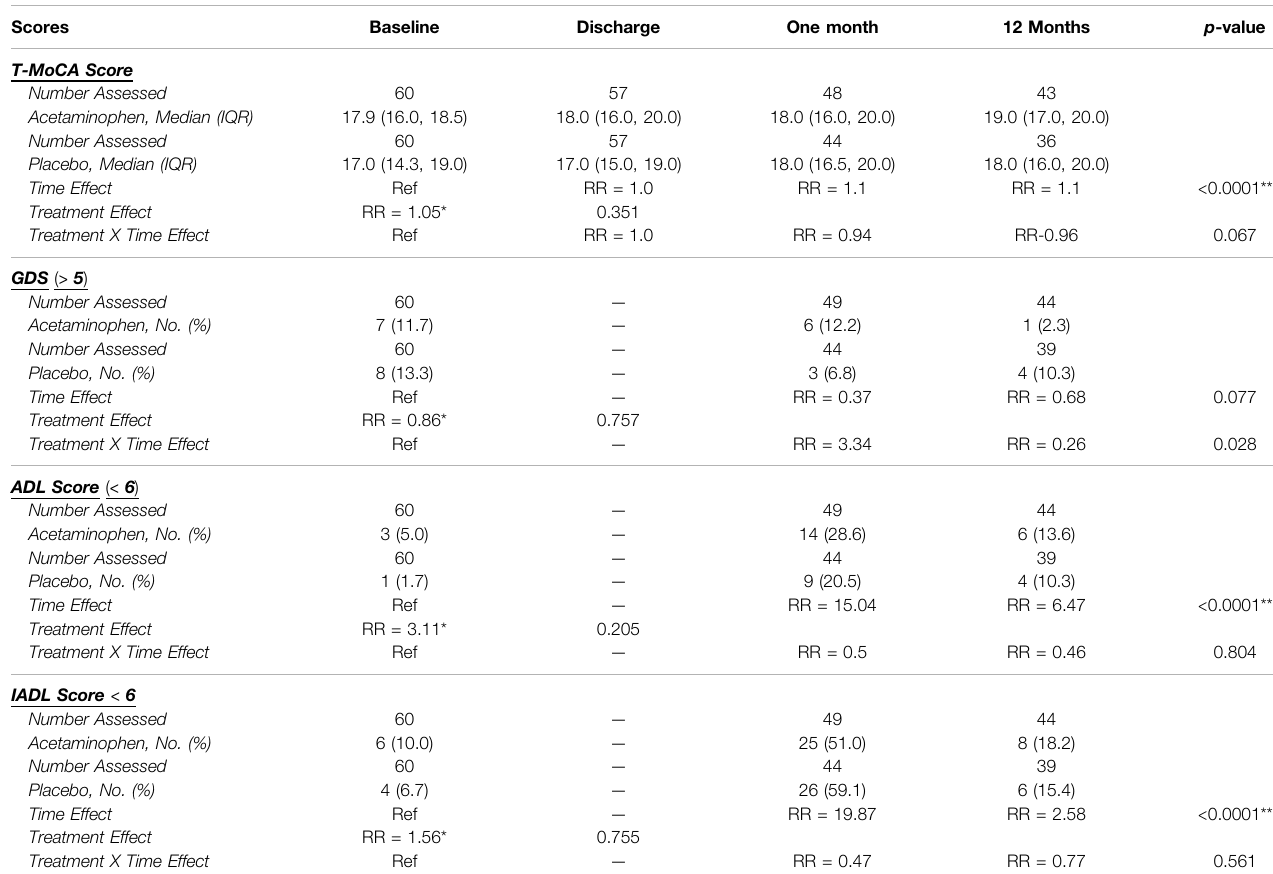
TABLE 2 | Overall Results for Cognitive and Functional Outcomes Over Time. Generalized estimating equations were performed to test whether analgesic group, time, and theirinteraction predictedT-MoCA,GDS,ADL,andIADLscores.Thenumberofpatientsassessedisdisplayed foreachoutcomeasitvariesover timeandbytreatment groupduetowithdrawals,assessmentsrefused,etc.Median(IQR)aredisplayedforT-MoCAscoresandFrequency(%)aredisplayedforGDS,ADL,andIADLscoreswhich have been dichotomized. Risk ratios are displayed for the time effect with baseline as the reference, for the treatment effect with placebo as the reference, and for the time*treatment interaction with baseline-placebo as the reference. A signi fi cant time effect was found for T-MoCA, ADL, and IADL. Although the GDS treatment*time interaction p -valueis < 0.05,becausetheprimarycomparisonswereinsigni fi cant,theinteractionwasconsideredinsigni fi cant . ( T-MoCA:Telephonic-Montrealcognitive assessment, GDS: Geriatric depression scale, ADL: Activities of daily living, IADL: Instrumental activities of daily living, IQR: Interquartile range